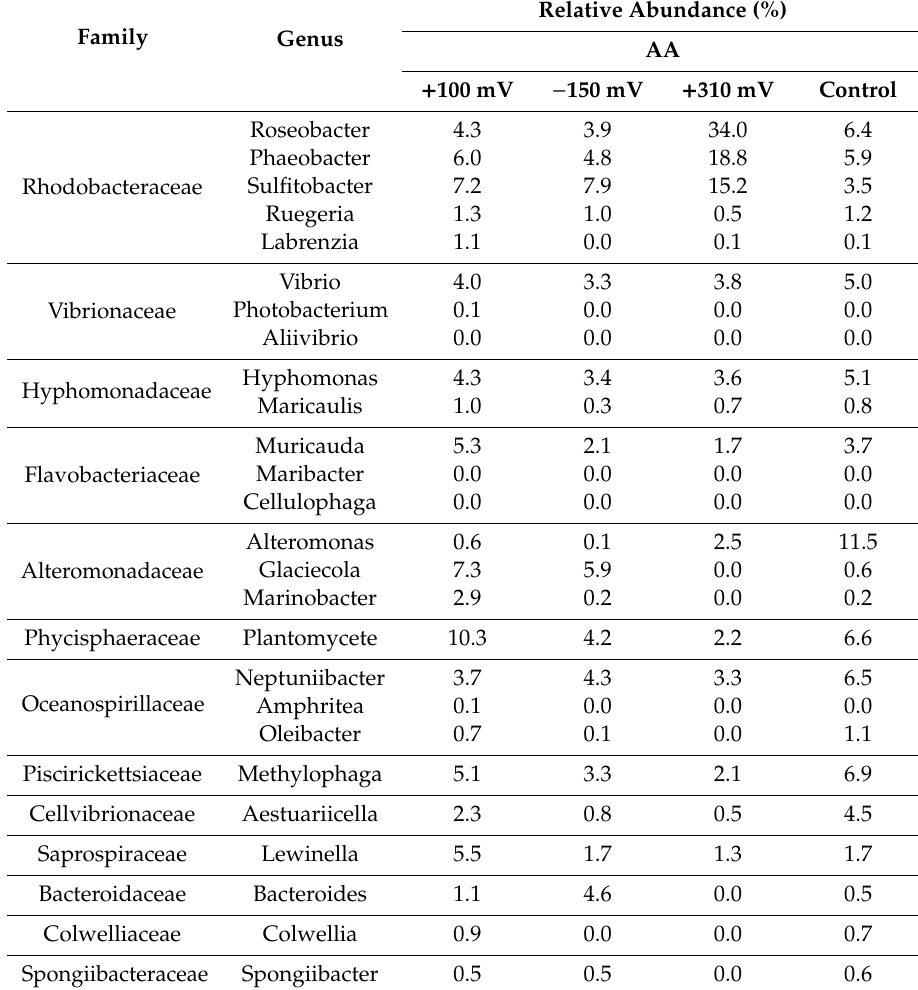
Table 1. Relative abundance (%) of most-abundant genre identified by amplicon analysis (AA) in each sample ( + 100 mV, − 150 mV, + 310 mV vs. Ag / AgCl and